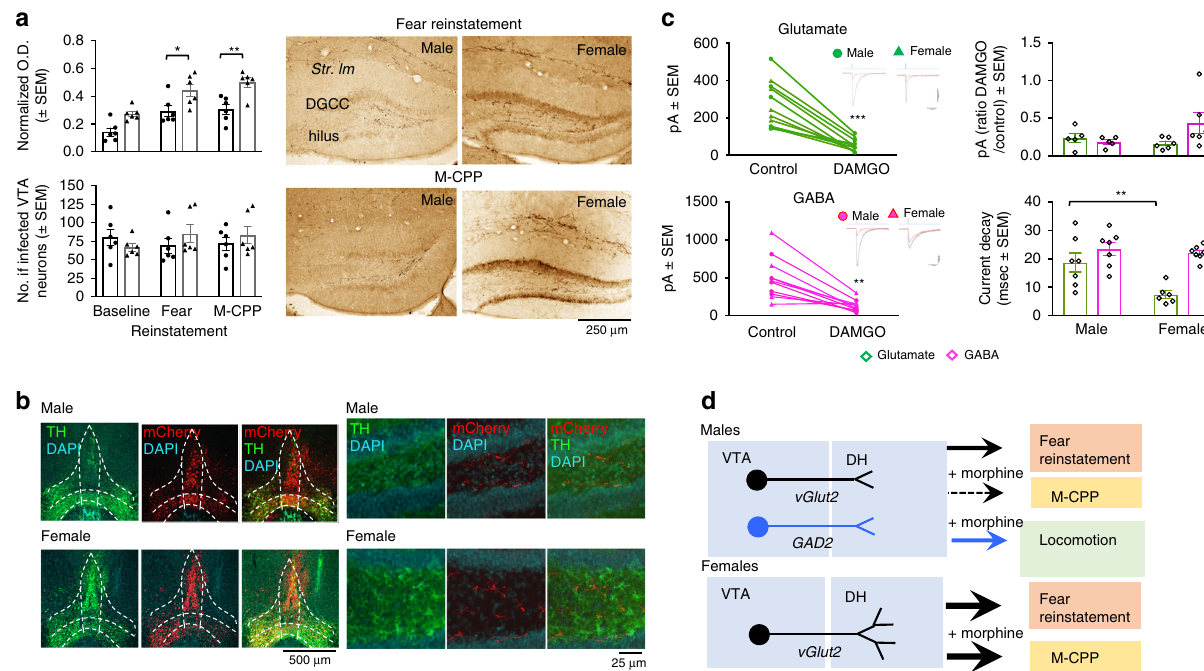
Fig. 7 Sex differences in the density of VTA → DH vGlut2 terminals and their effects on excitatory transmission. a Density of vGlut2-positive VTA-DH terminals in DG under baseline conditions ( n = 6 males, n = 6 females), after fear reinstatement ( n = 6 males, n = 6 females), and after M-CPP ( n = 6 males, n = 6 females) revealed signi fi cant sex differences (top left, two-way ANOVA F 1,30 = 34.71, P < 0.0001), with females showing signi fi cantly higher density after reinstatement (* P = 0.0216) and after M-CPP (** P < 0.0040]. In the same mice, the number of VTA-infected neurons was similar [bottom left, Sex: F (1, 30) = 0.3486, P = 0.5593, Group: F (2, 30) = 0.1023, P = 0.9031]. These differences are illustrated with mCherry images of DG (right). b In either sex, vGlut2 VTA DH terminals did not show detectable co-localization with tyrosine hydroxylase (TH). c Optogenetic stimulation of VTA terminals triggered glutamate and GABA currents whose amplitude was signi fi cantly decreased in the presence of DAMGO [glutamate [ n = 11 ( fi ve males and six females): F (1, 9) = 48.24, *** P < 0.0001; GABA ( n = 11): F (1, 9) = 24.93, ** P = 0.0007]. A signi fi cant effect of DAMGO was also found with nested ANOVA factoring for data from individual mice [ F ( 1,21) = 15.40, P = 0.017]. The amplitude ratios of these currents did not differ between sexes [two-way ANOVA, F = 1.118, P = 0.3044], however, there were signi fi cant effects of sex [ F = 8.302, P = 0.0082] and current type [ F = 19.98, P = 0.0002] on (1, 18) (1, 24) (1, 24) the current decay. Post hoc tests revealed that the decay of glutamate currents was signi fi cantly faster in females (** P = 0.0033) than in males, whereas GABA currents had similar decay rate ( P = 0.8949). Nested ANOVA including individual mice as a variable also revealed a signi fi cant effect of sex on current decay [ F ( 1,21) = 9.2065436, P = 0.038]. d Summary of the effects of glutamatergic and GABAergic VTA → DH terminals in fear reinstatement and M-CPP. The thickness of the arrow re fl ects the strength of the